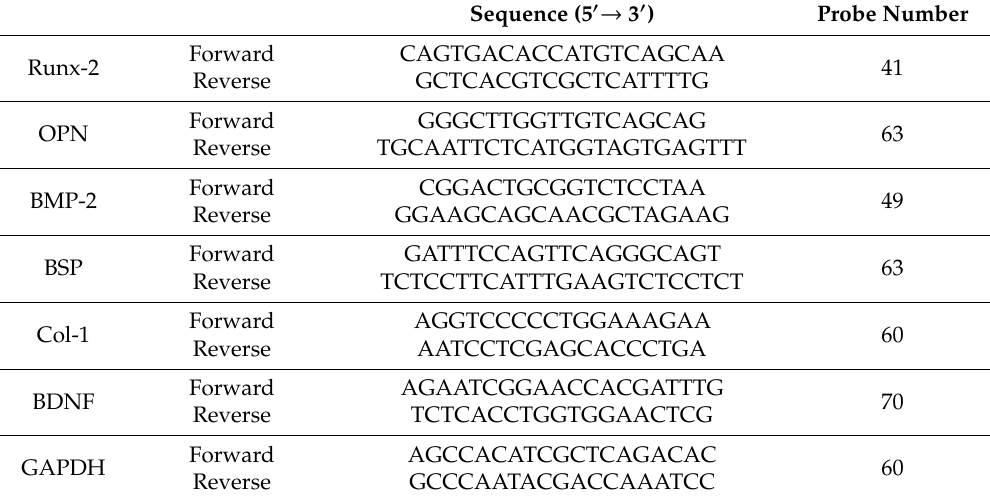
Table 2. Primer and probe combination used for the real-time